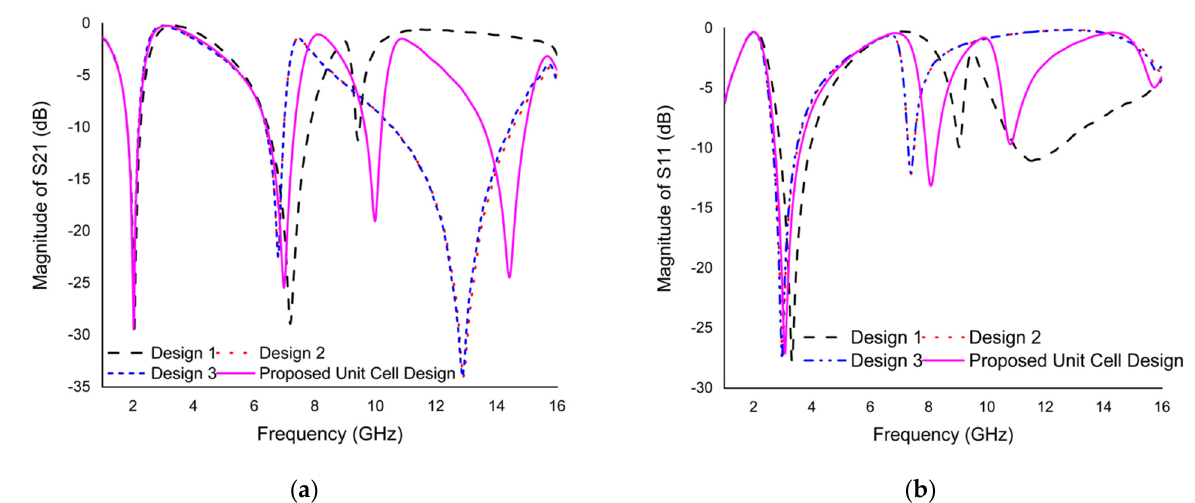
Figure 4. ( a ) The S 21 plot on different design approaches. ( b ) The S 11 plot on different design ap-